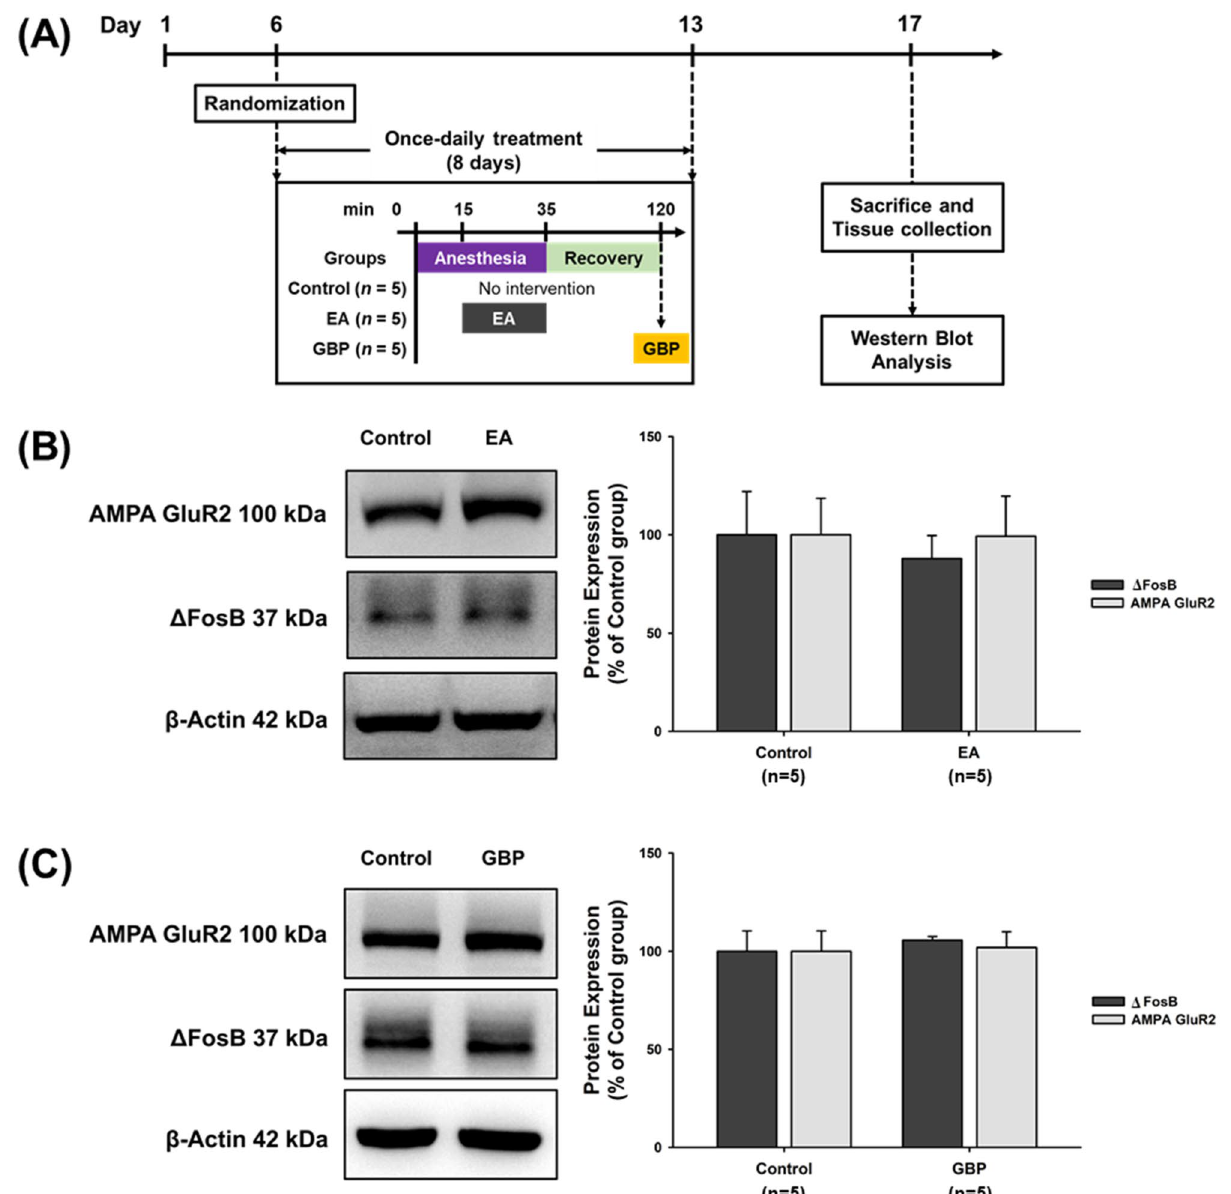
Figure 4. EA or GBP alone did not affect ΔFosB and GluR2 expression in cocaine-naïve mice. ( A ) Timeline for the experimental procedures. ( B , C ) Cocaine-naïve mice were treated with EA or GBP (1 mg/kg i.p.). Levels of ΔFosB and GluR2 expression were examined by Western blotting ( n = 5 per group). The original Western blot images are available in Supplementary Figure S11 and S12, respectively. The bar graphs show the quantification of protein from ( B , C ). The same control group was used for both Western blotting assays. Abbreviations: Control = Cocaine-naïve mice; EA = cocaine-naïve mice with EA treatment; GBP = Cocaine-naïve mice with i.p. GBP (1 mg/kg)